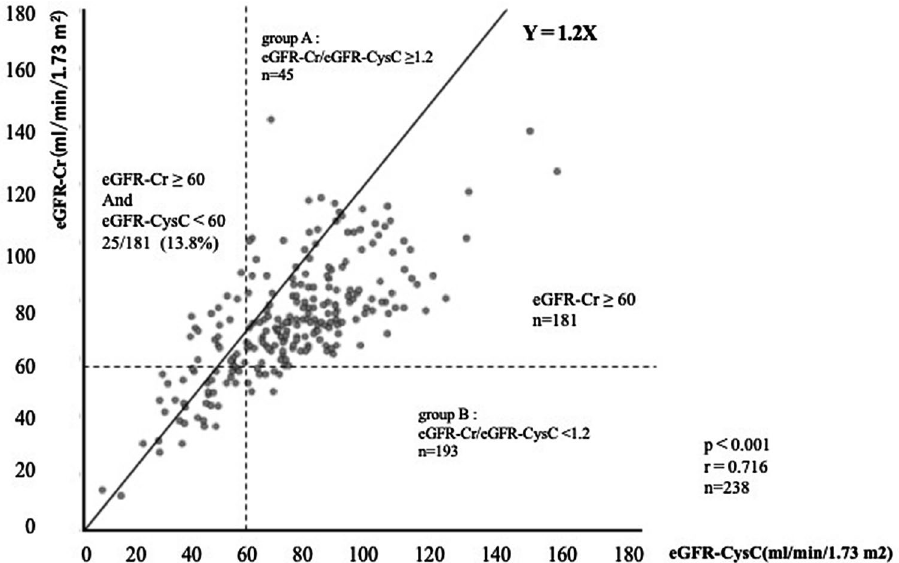
Figure 1. Relationship between eGFR-Cr and eGFR-CysC. eGFR-Cr; estimated glomerular filtration rate using creatinine. eGFR-CysC; estimated glomerular filtration rate using cystatin C. The correlation between eGFR-Cr and eGFR-CysC was significant (r = 0.715, p < 0.0001). However, 25 (13.8%) of 181 patients with eGFR-Cr ≥ 60 mL/min/1.73 m 2 showed eGFR-Cys < 60 mL/min/1.73 m 2 .